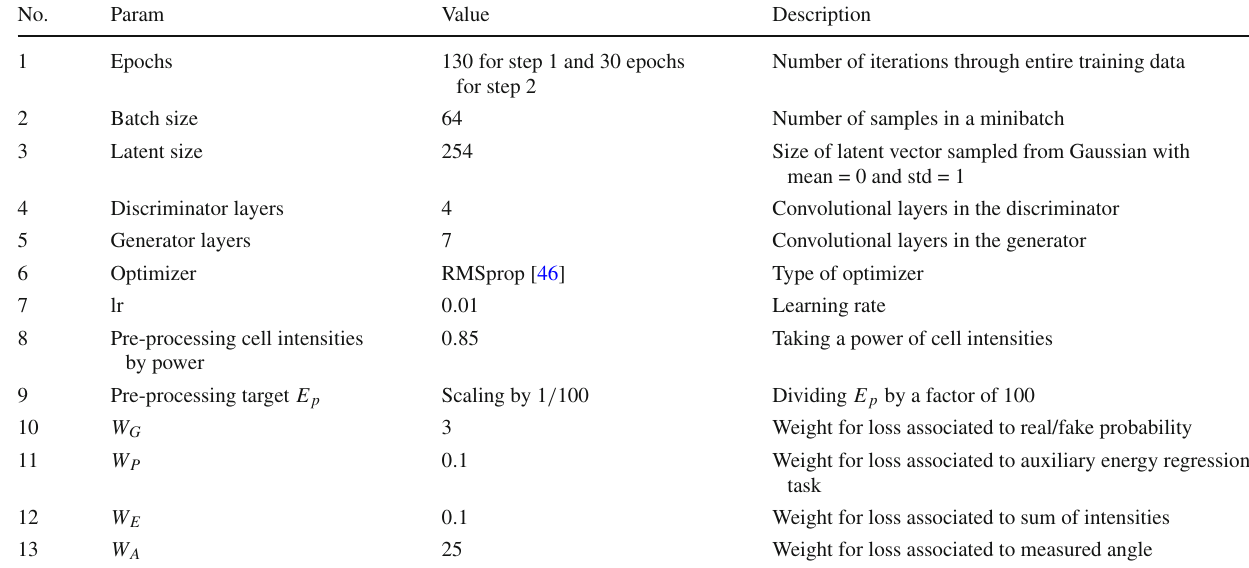
Table 4 Hyperparameters for 3DGAN fully optimized version No.